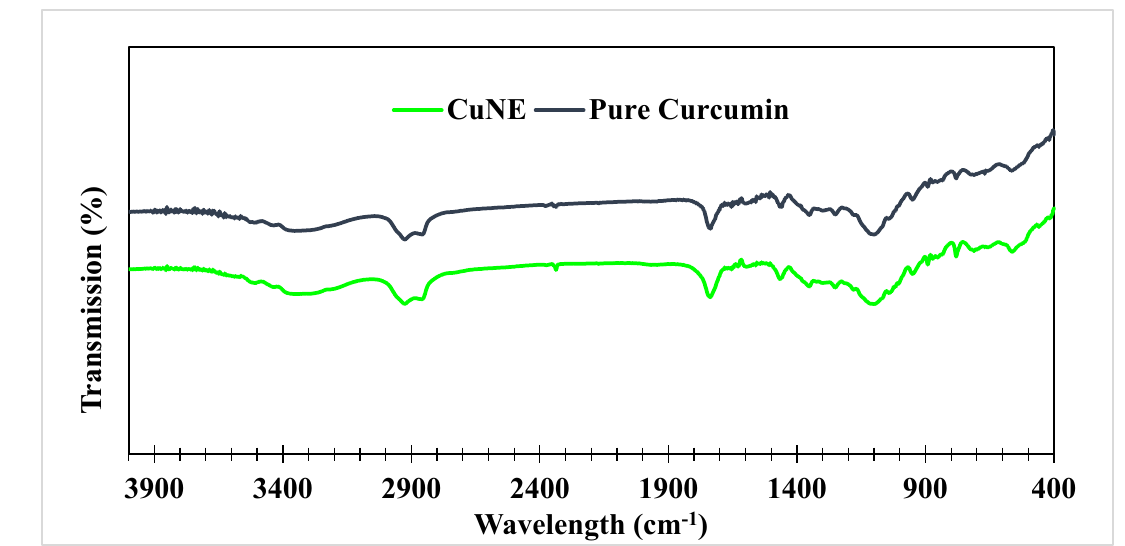
Figure 3. FTIR spectra Free curcumin and Curcumin nanoemulsion .